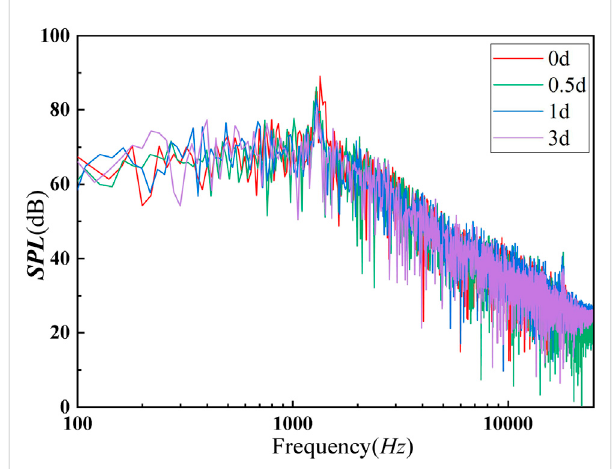
FIGURE 14 Frequency domain acoustic results with different offsets.